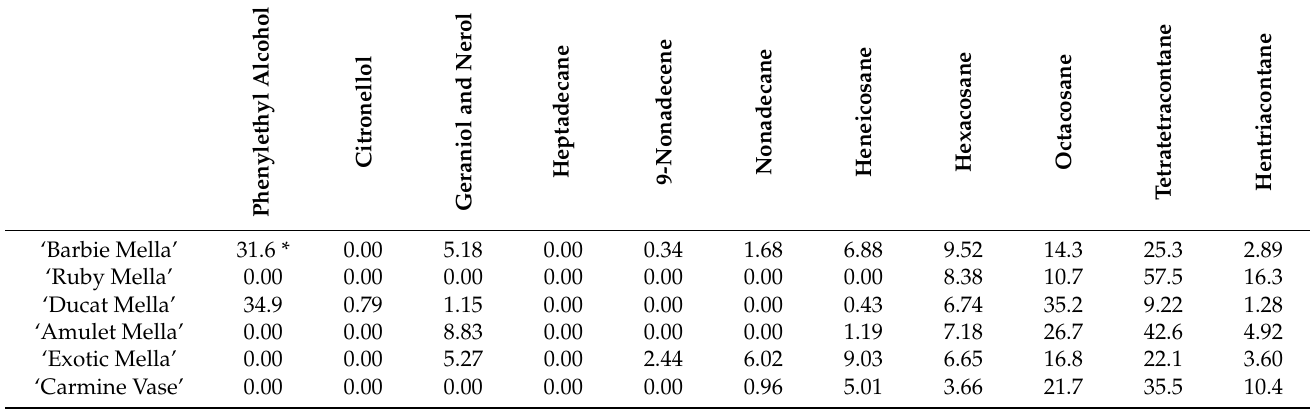
Table 6. Volatile compounds determined in investigated ‘Mella’